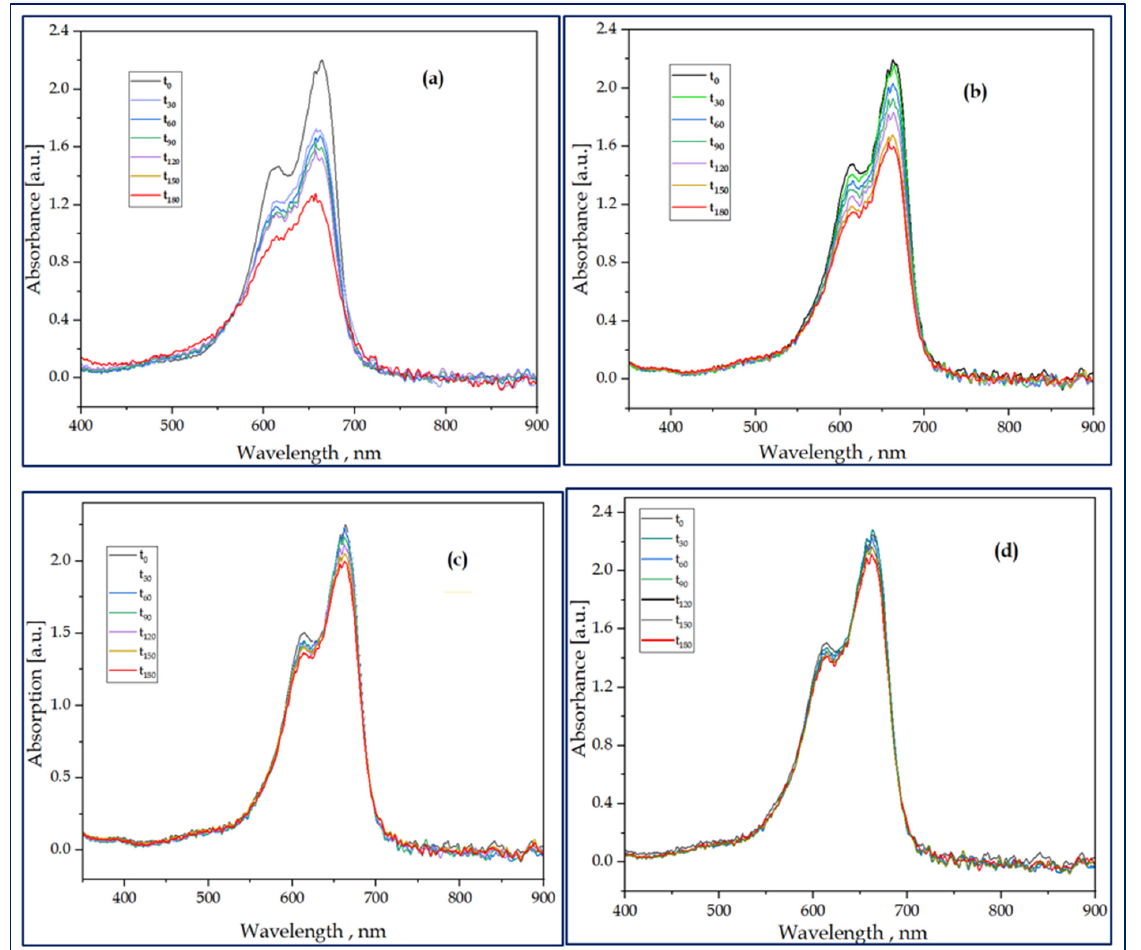
Figure 7. Photocatalytic decolorization of the MB dye in the presence of TiO 2 ( a ), TiO 2 /Al 2 O 3 thermal ALD ( b ), TiO 2 /Al 2 O 3 plasma ALD ( c ), and MB dye ( d ).